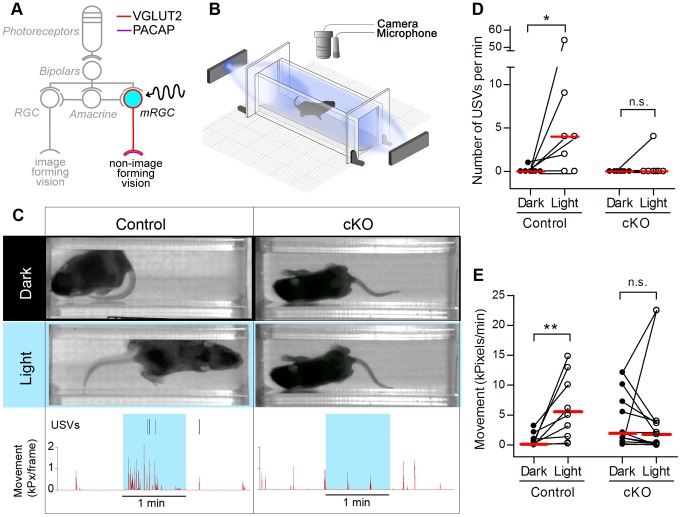
Glutamatergic signaling from mRGCs is required for photoaversion and light-evoked ultrasonic vocalizations in neonatal mice.(A) Schematic of photoreception and visual pathways in the retina of neonatal mice. Until postnatal day 10, mice rely on intrinsic photoreception in mRGCs for light-mediated functions as visual signaling from cones, rods and bipolar cells has not yet matured. After P10, visual signals from rods and cones excite RGCs including mRGCs. The schematic shows that neurotransmission from mRGCs relies on glutamate and PACAP. (B) Experimental setup to test neonatal photoaversion (see methods). (C) Examples of movement and vocal responses to light in control and in cKO mice. Exposure to light evoked increased movement and distress USVs in the control but not in the cKO mouse. The timing of individual USVs is marked by ticks at the top of the graph. Locomotive movement is presented as the amount of net movement in kiloPixels per frame (see Methods). (D, E) Summary of light-induced responses. The number of USVs (D) and the amount of net movement (E) significantly increased in the control mice (n = 7 for USVs and n = 9 for movement) but not in the cKO mice (n = 7 for USVs and n = 10 for movement). Red lines are median values. Asterisk (*) indicates P<0.05; (**) indicates P<0.01; (n.s.) indicates P>0.05 (Wilcoxon signed rank test).